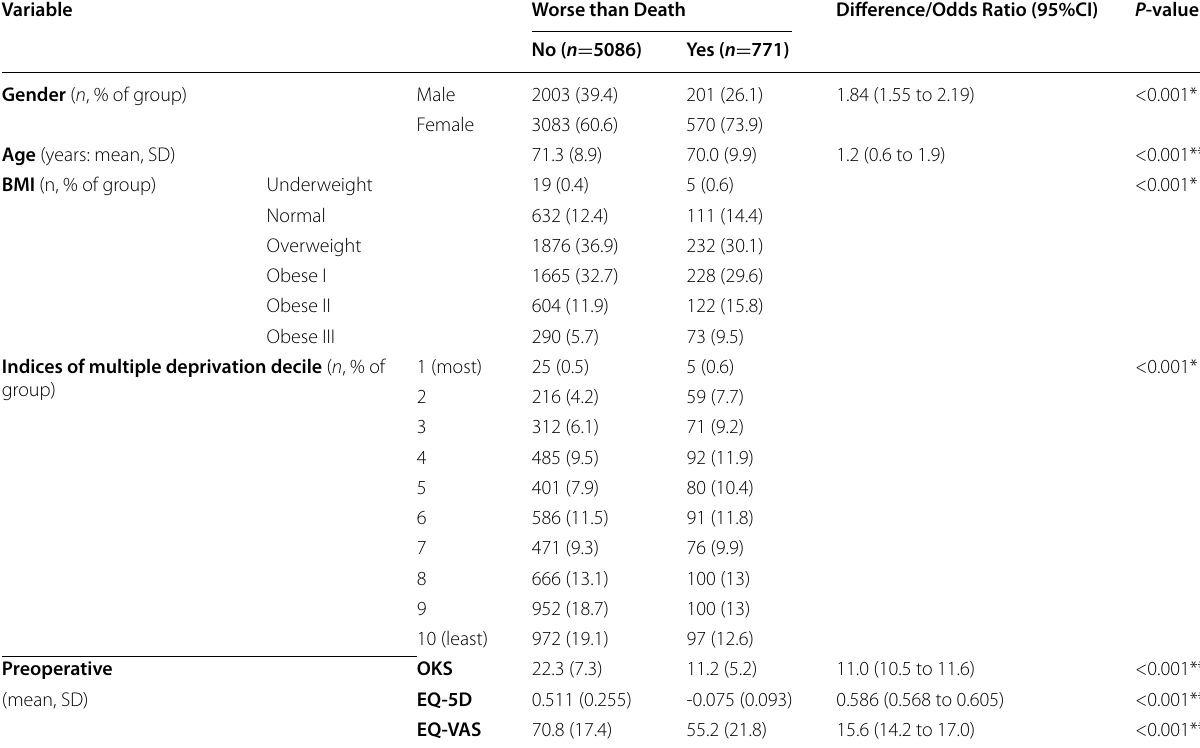
Table 1 Unadjusted analysis assessing preoperative variables associated with a preoperative health status of worse than death in patients awaiting a total knee